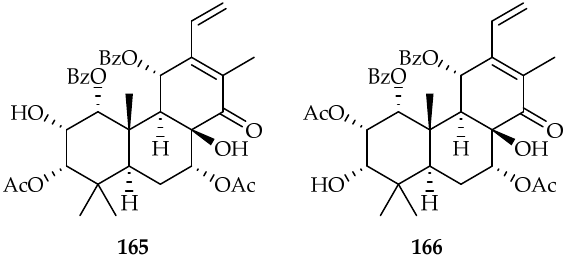
Figure 69. Structures of spicatusenes B 165 and C 166 [108].